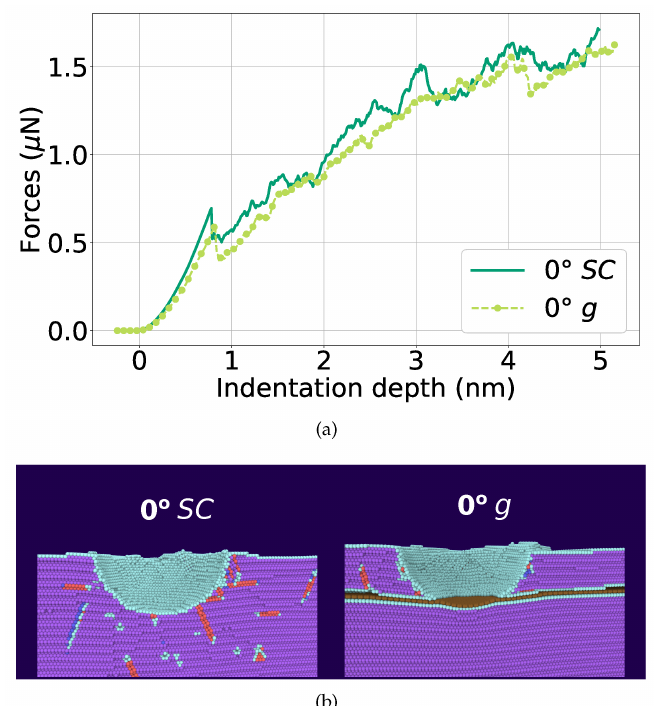
Figure 9. ( a ) Force–indentation depth curve during nanindentation of single-crystalline (SC) Ni (dark-green line) and Ni with graphene (g) (light-green line). ( b ) The snapshots of the structure for pure Ni (SC) and Ni with graphene (g) at an indentation depth of d = 4.1 nm, immediately before dislocation nucleation in the lower Ni block. Atoms are colored according to common-neighbor analysis. Purple: fcc; red: stacking faults; cyan: other defects; brown: graphene. Reprinted with permission from